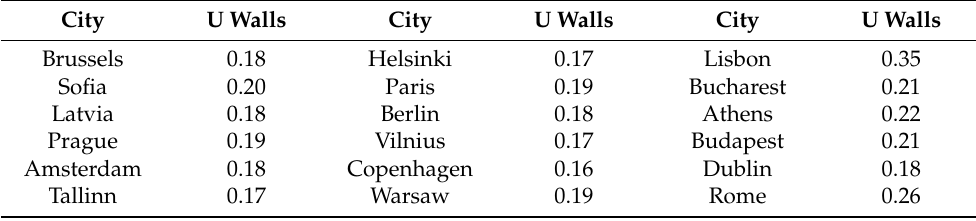
Table 7. Thermal transmittance (W/m 2 K) according to EURIMA